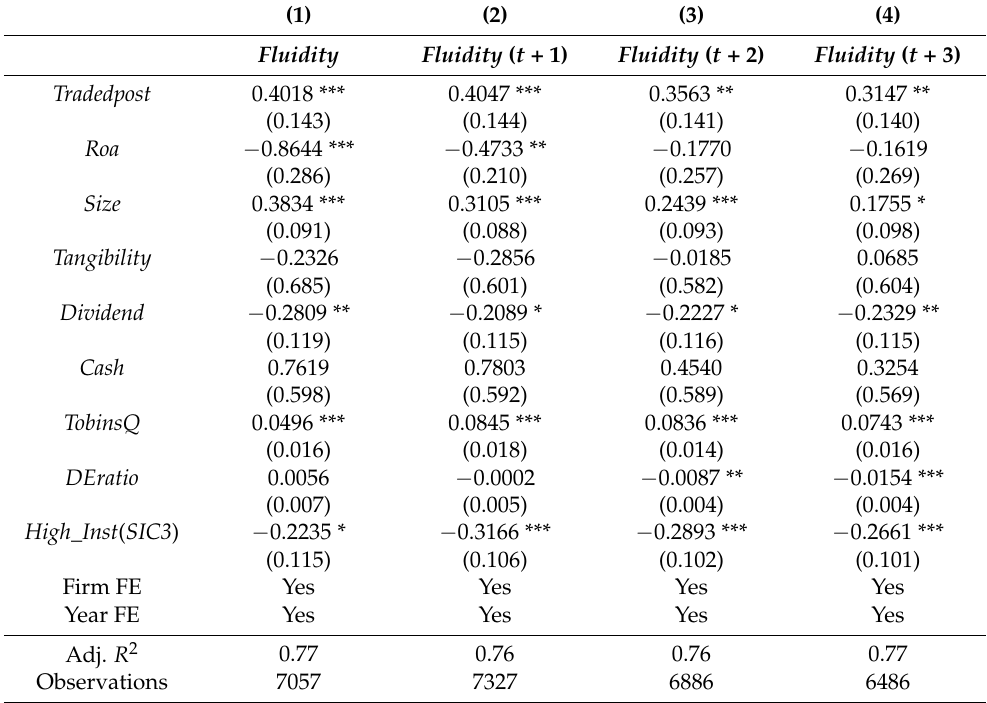
Table 4. Overlap weight propensity score matching. This table reports the results for model (1) with propensity score matched samples using overlap weights approach (Li et al. 2018). Control firms were matched based on CDS initiation year and lagged covariates, including Roa, firm size, tangibility, debt-equity ratio, and institutional presence. The firm-year observations of all matched firms are included in the regressions. Dependent variables include Fluidity and its lead measures (i.e., t + 1 to t + 3). Standard errors were clustered by firms and reported in parentheses. Lagged firm-specific controls and firm and year fixed effects are included in all specifications. Coefficients with *, **, or *** indicate a significance level of 0.10, 0.05, or 0.01, respectively. For detailed definitions of variables, please refer to Appendix A Table